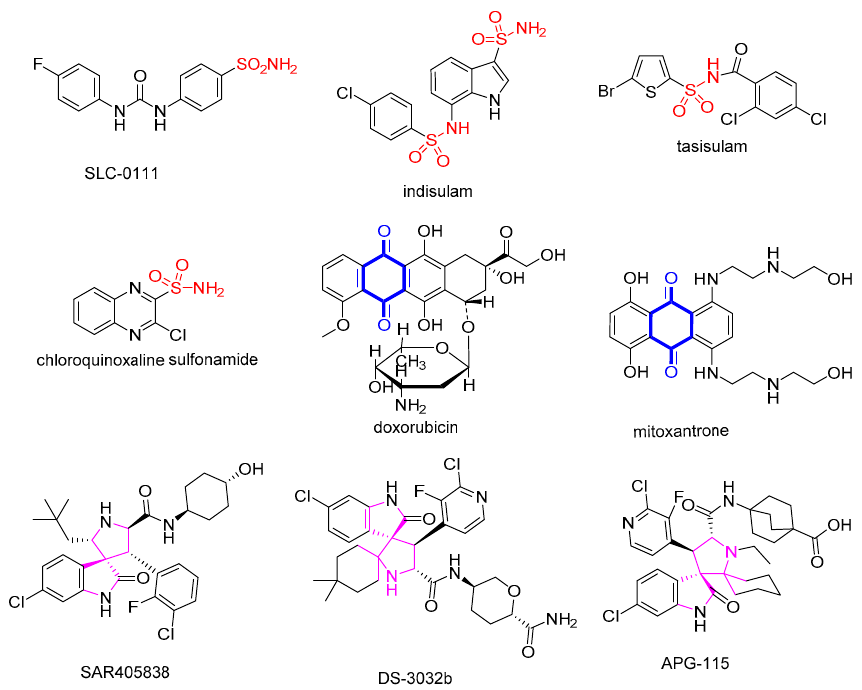
Figure 1. Sulfonamide, quinone, and spirocyclic antitumor agents.